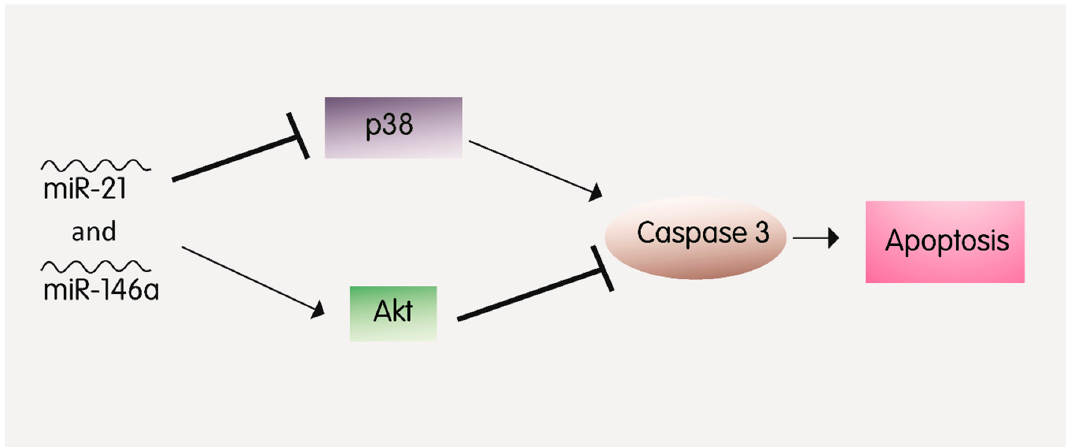
Figure 4. The synergistic role of miR-21 and miR-146a in apoptosis attenuation: miR-21 and miR-146a downregulate p38 and repress Akt inhibition, consequently leading to a decrease in Caspase 3 expression and hence, decreased apoptosis.